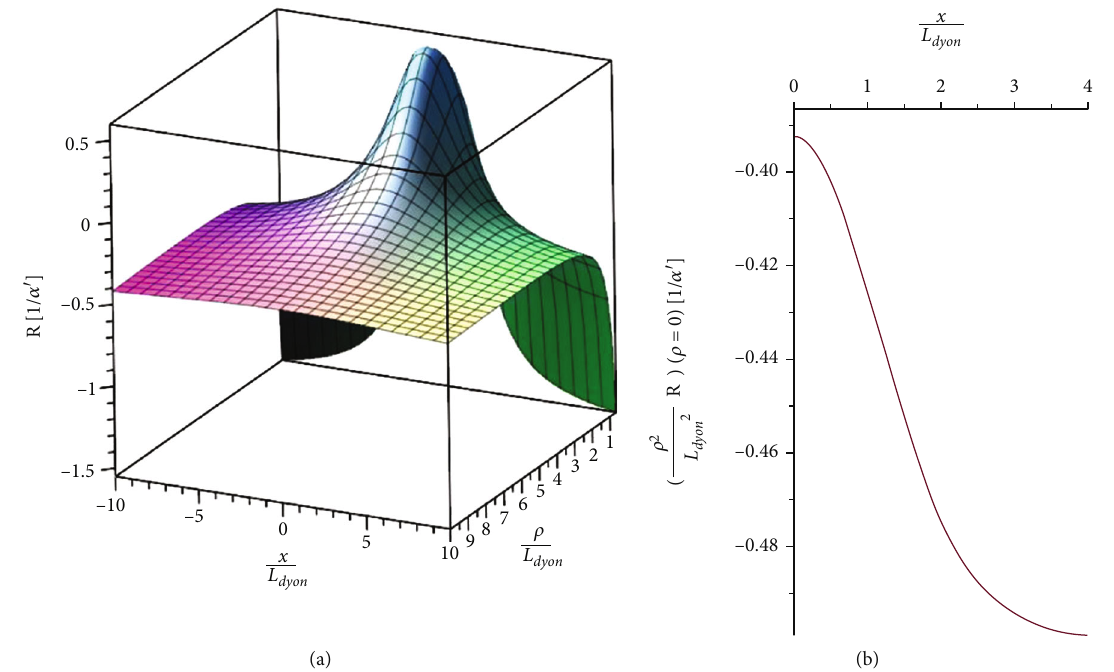
Figure 4: Rotating magnetic monopole: in (a), the scalar curvature, R , in units of 1/ α ′ , is plotted as a function of the dimensionless, cylindrical cooordinates ρ / L and x / L . In (b), the scalar curvature, which has been rescaled to remove its divergent behavior, is dyon dyon plotted as a function of x / L at ρ = 0 . The charge of the monopole is q = 4 π , i.e., the electric charge q dyon m mass is 4 π M . The Yang-Mills coupling constant g = 1 gluon D 3 a plot of ρ 2 R , evaluated at ρ = 0 . The purpose of scaling by ρ 2 is to remove the divergent part of the scalar curvature.